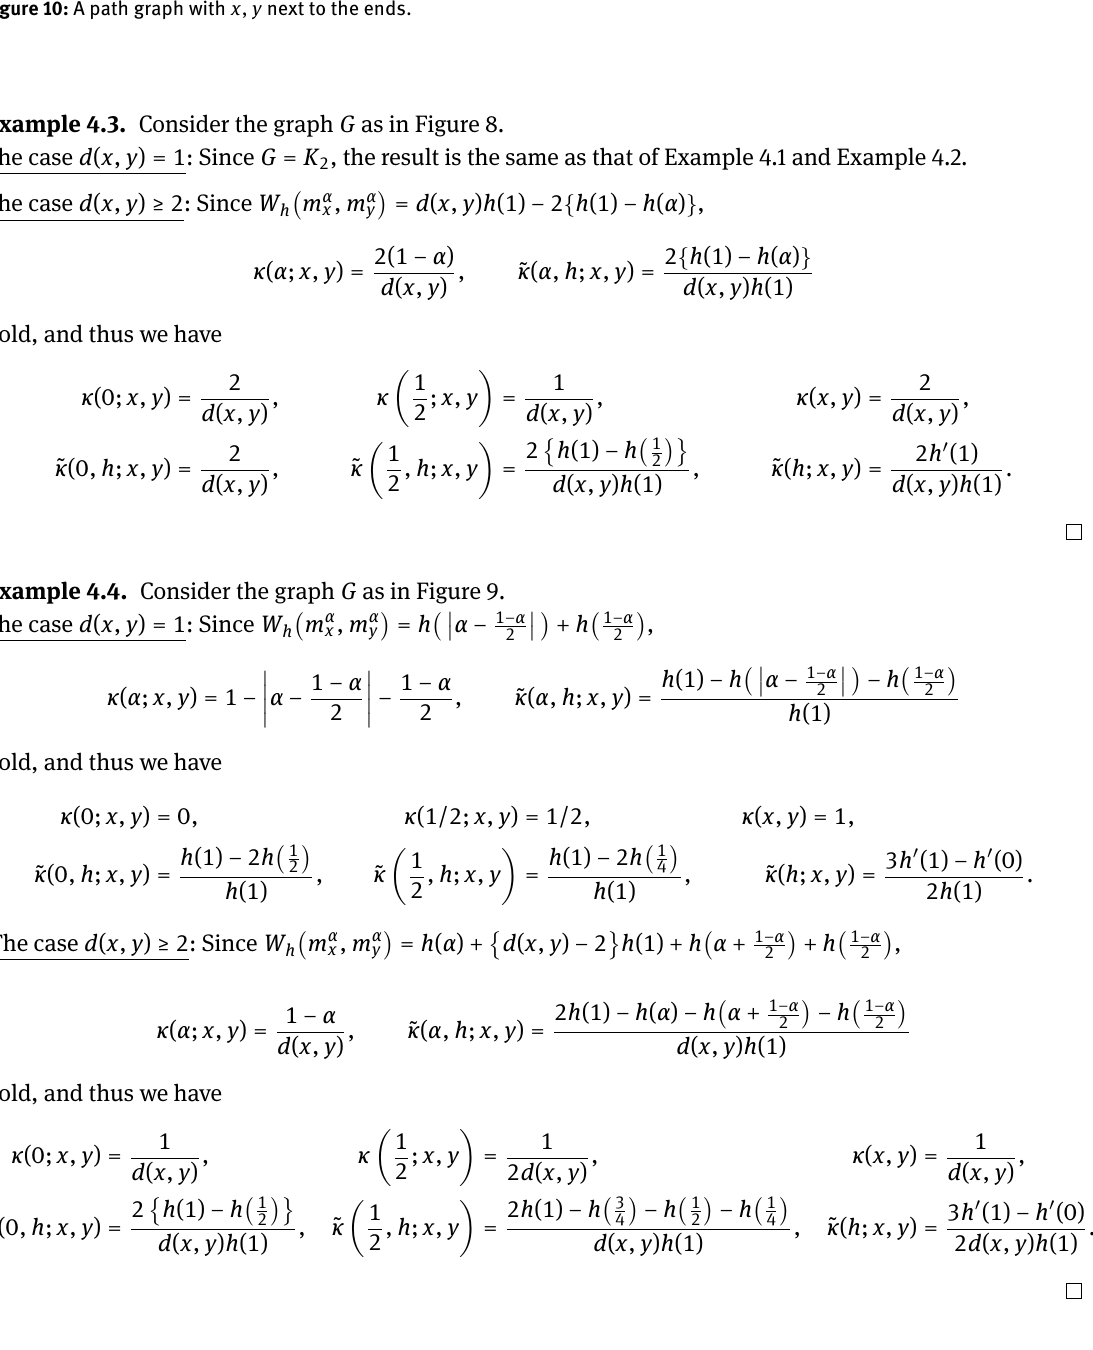
Figure 9: A path graph with x on one end and y next to the other end.